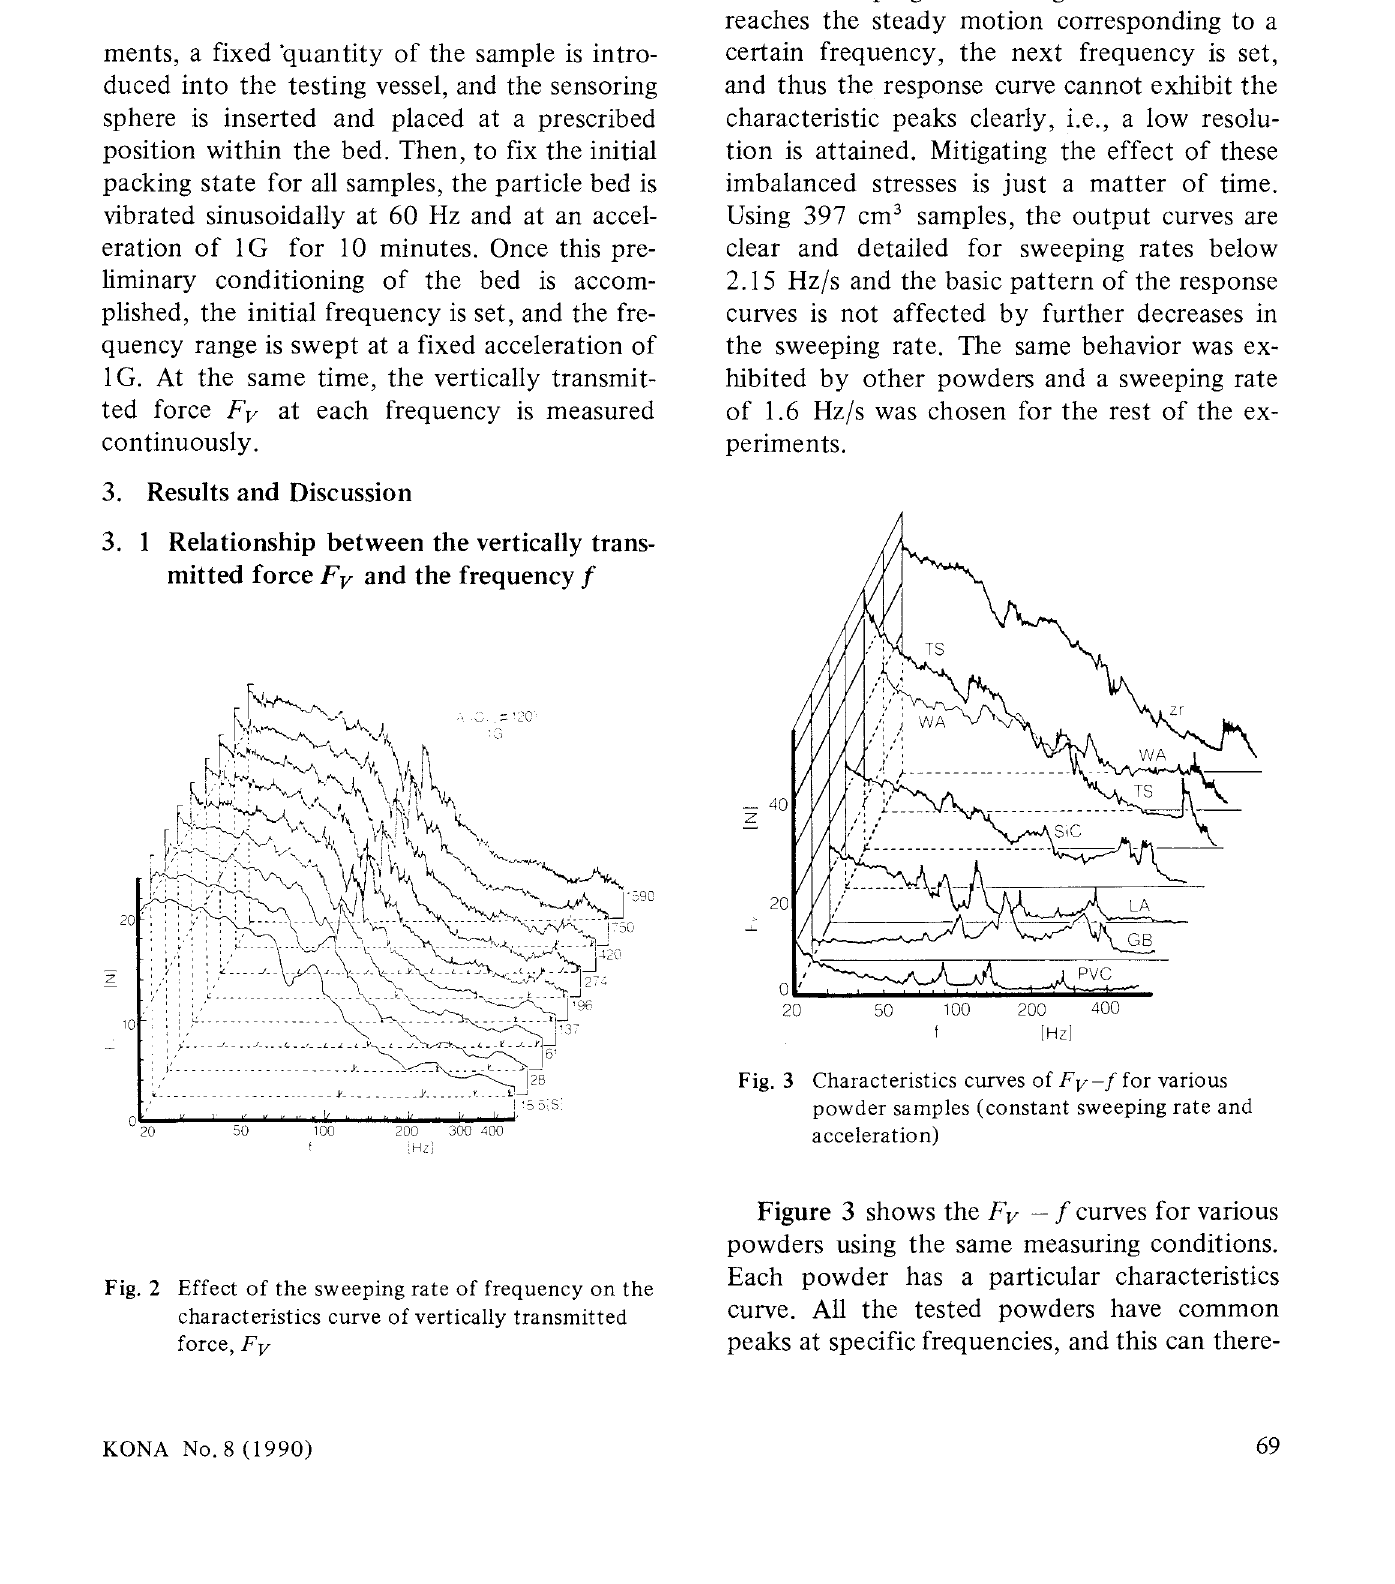
Fig. 3 Characteristics curves of Fv-ffor various powder samples (constant sweeping rate and